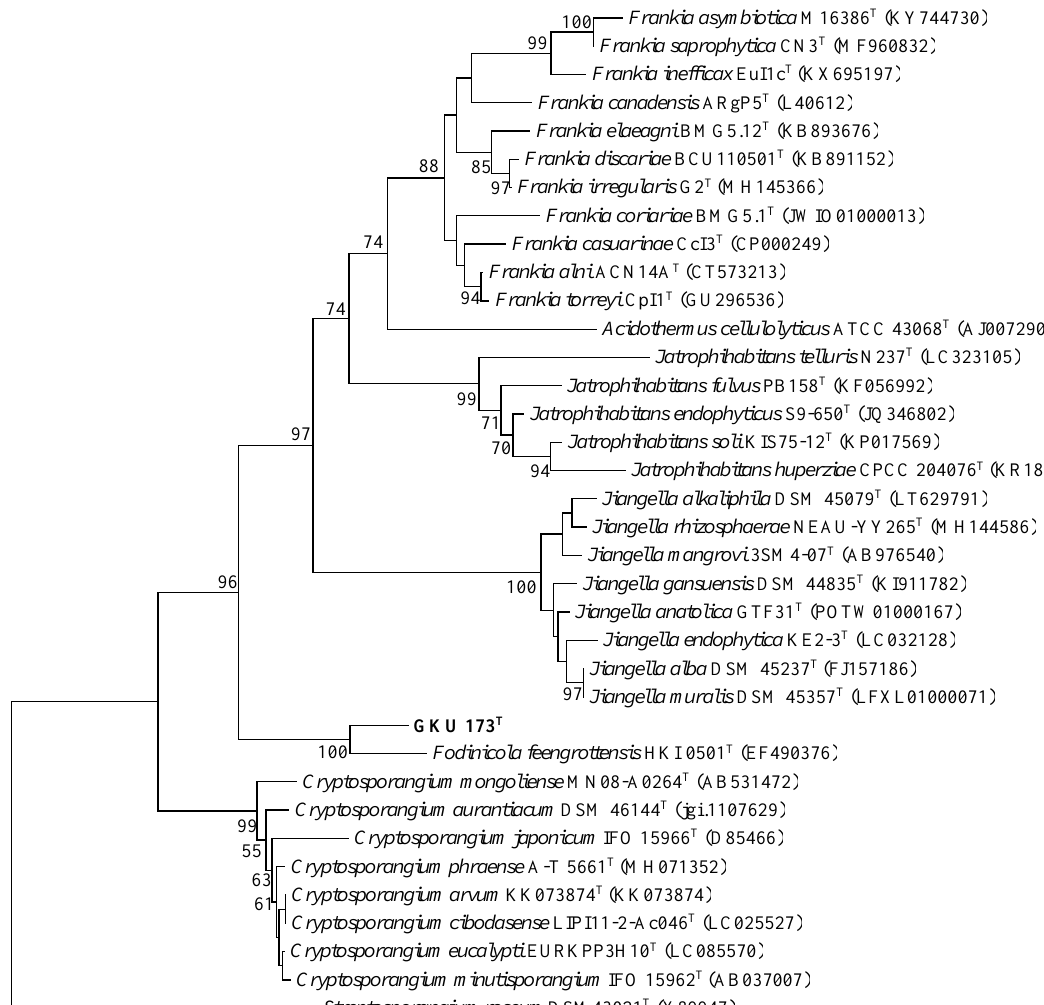
Figure 2. Neighbor-joining phylogenetic tree on the basis of 16S rRNA gene sequences of strain GKU 173 T and related species. Streptosporangium roseum DSM43021 T was used as an outgroup. Numbers at nodes refer to bootstrap values (based on 1000 replicates; only values > 50% are shown). Bar, 0.005 nucleotide substitutions per